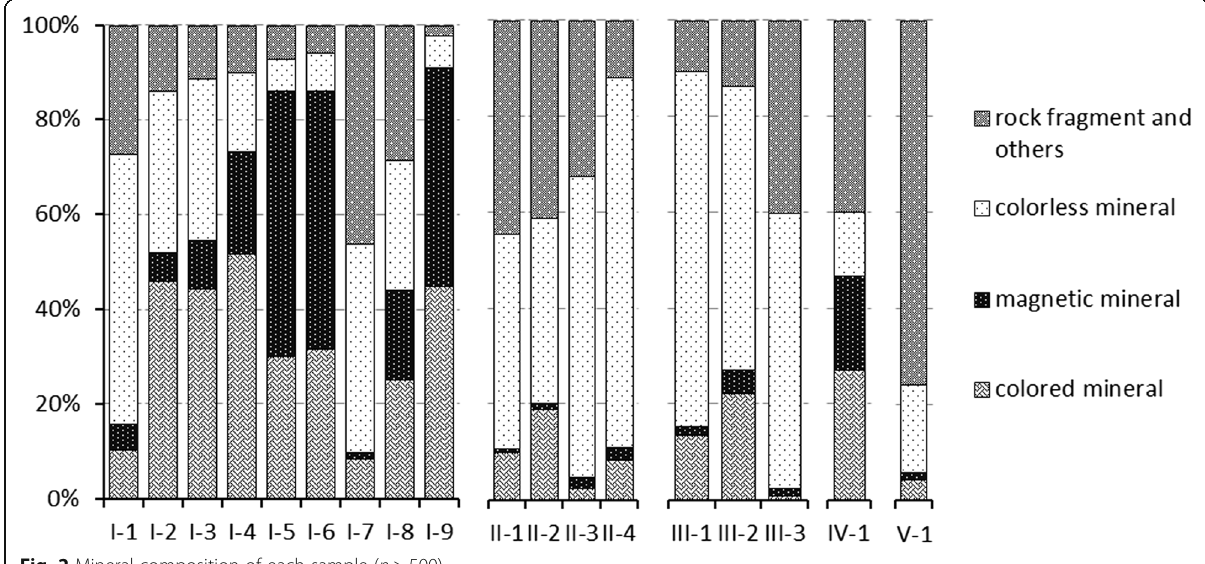
Fig. 2 Mineral composition of each sample ( n > 500)